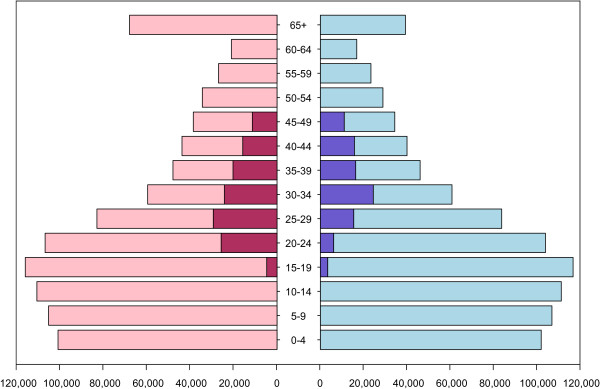
Population distribution and HIV prevalence. Population data are from the 2006 Census for women (pink) and men (light blue). HIV prevalence data, from the 2009–2010 Demographic and Health Survey is shown for women (red) and men (blue) aged 15 to 49 years old.